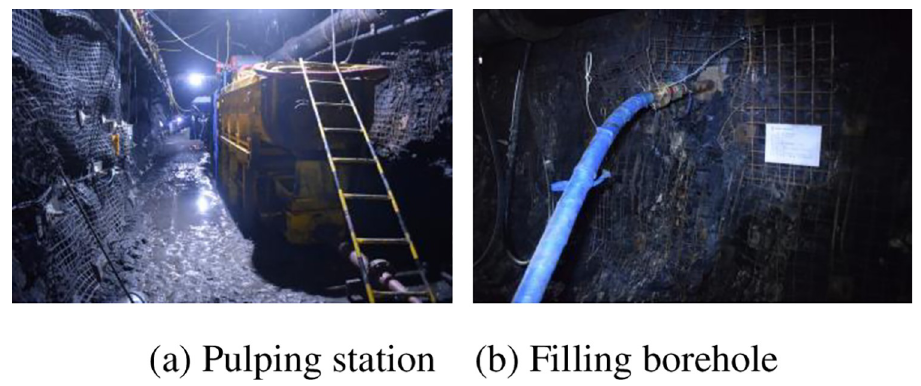
Fig 11. Site of adjacent grouting filling. (a) Pulping station. (b) Filling borehole.